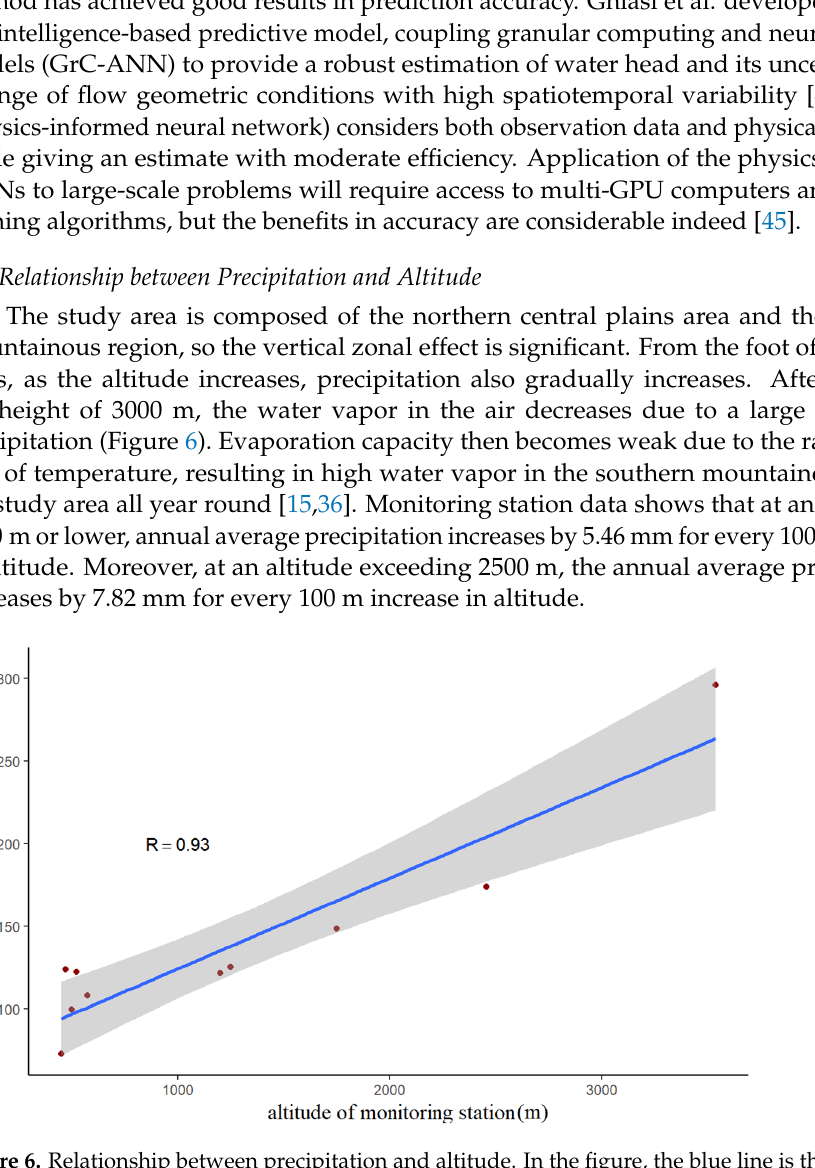
Figure 6. Relationship between precipitation and altitude. In the figure, the blue line is the regression line which represents the optimal parameters, the gray area is enclosed by the upper and lower confidence bounds under the 0.95 confidence level, and the red points represent the meteorological